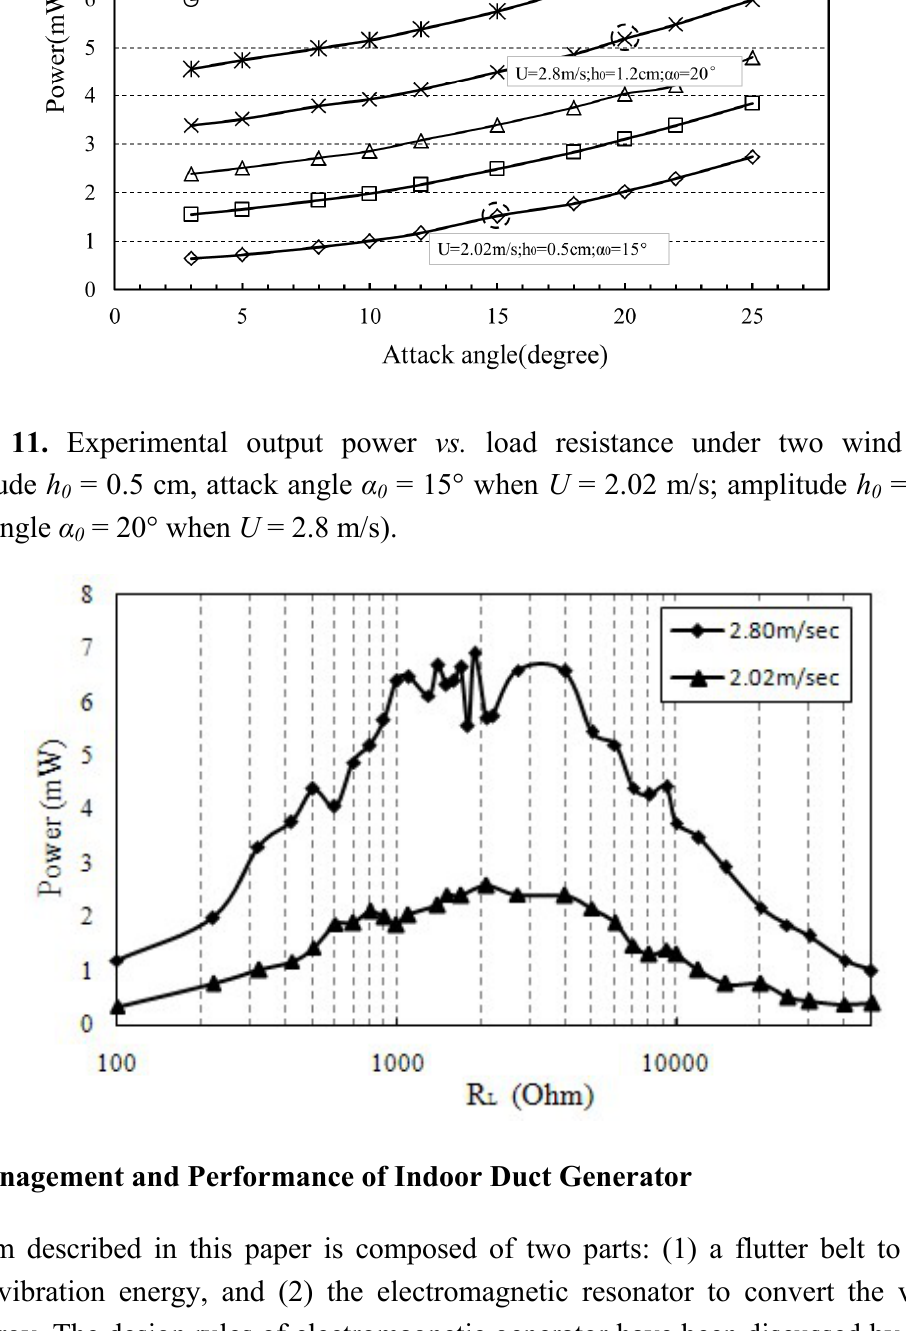
Figure 10. Simulation results of output power vs. vertical amplitude and attack angle.